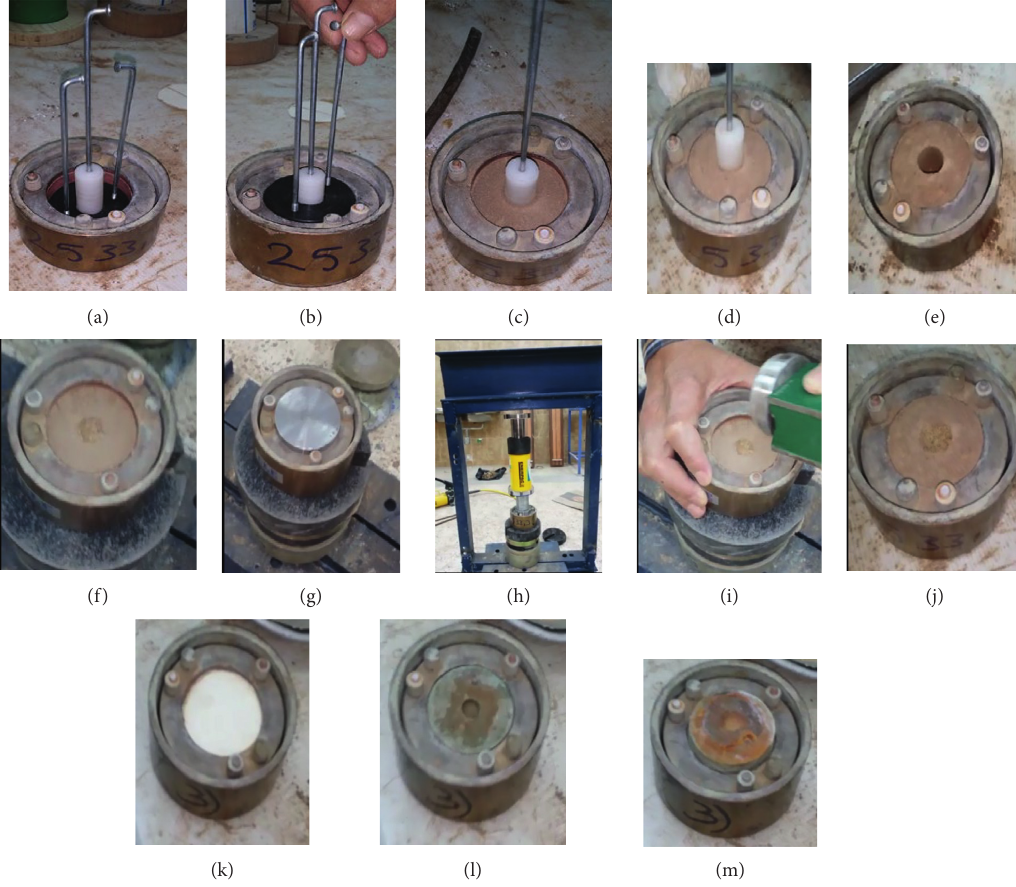
Figure 2: Used steps for preparing the expansive clay soil model reinforced with SP. (a) Placement of the TP and CHTP in the center of the Oedometer cell. (b) Removal of the CHTP and place the first clay layer around TP, then reposition of the CHTP over the first clay layer, and its slight compaction. (c) Removal of the CHTP and placement of the second clay layer around TP, then reposition of the CHTP over the second clay layer, and its slight compaction. (d) Removal of the CHTP and placement of the third clay layer around TP, then reposition of the CHTP over the third clay layer, and its slight compaction. (e) Extraction of the TF leaving a hole. (f) The hole was filled with sand/water mixture and compacted forming a sand pile. (g) Placement of the steel guide compaction plate. (h) Placement of the model under the hydraulic Jack to final compaction of the model. (k) Removal of the guide compaction plate. (i) The model was completed. (m) Filter paper was placed. (n) Upper porous stone was placed. (o) Loading cap was